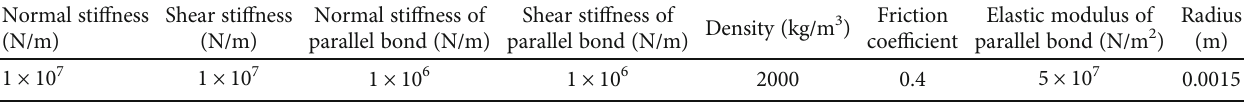
Table 2: Mesomechanical parameters of the barrier.